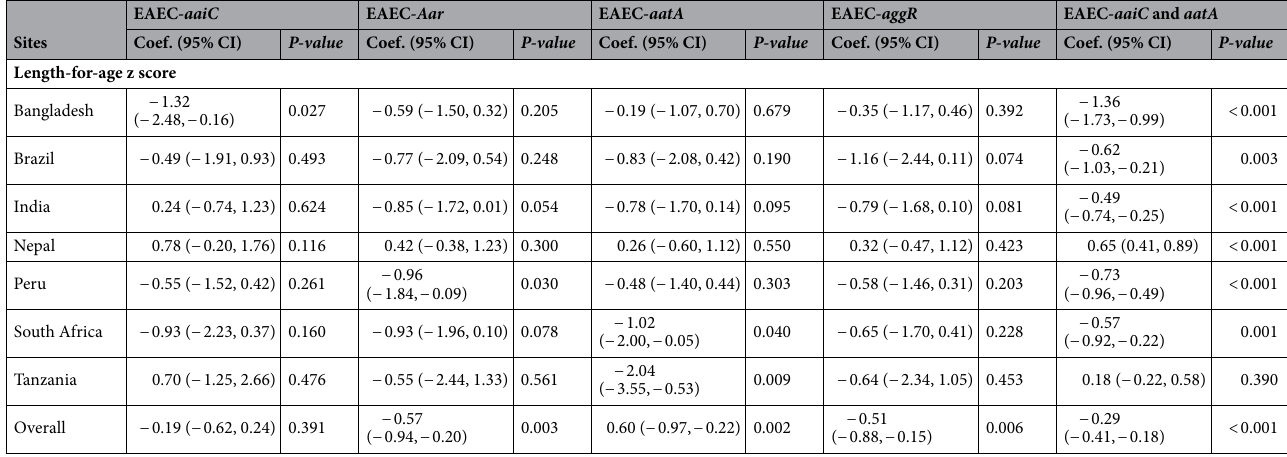
for aggR , strain carrying genes.